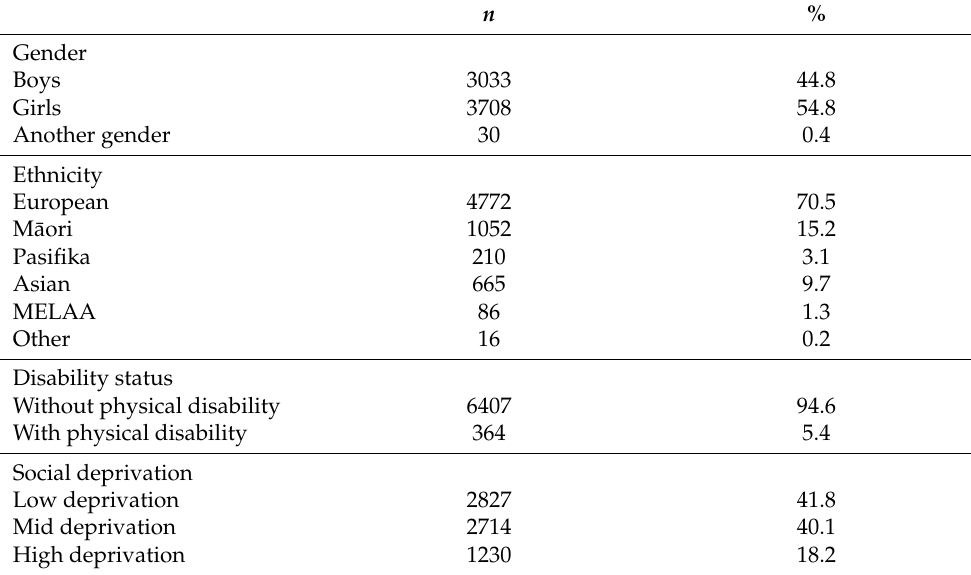
Table 1. Participant